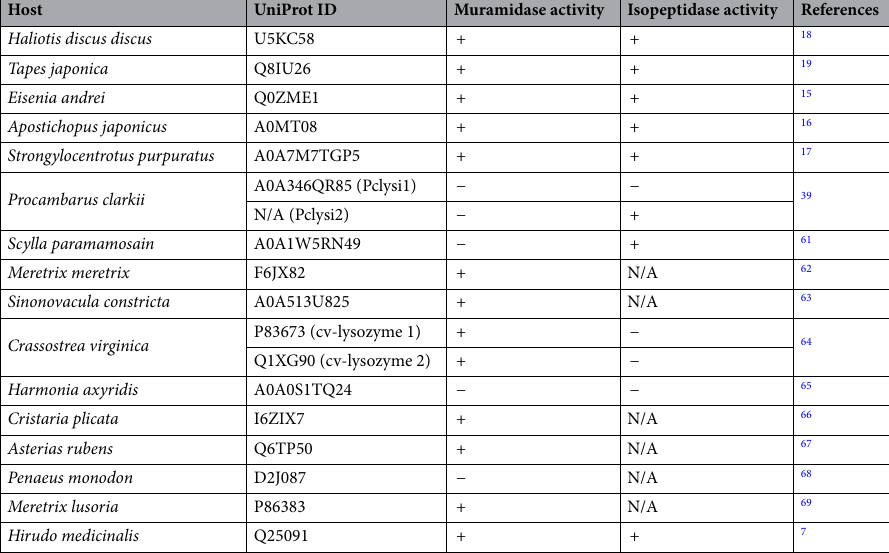
Table 1. Occurrence of muramidase and isopeptidase activities among destabilase homologs. Isopeptidase activity was confirmed via cleavage of L-γ-Glu-pNA and muramidase activity—via the destruction of Micrococcus lysodeikticus cellular